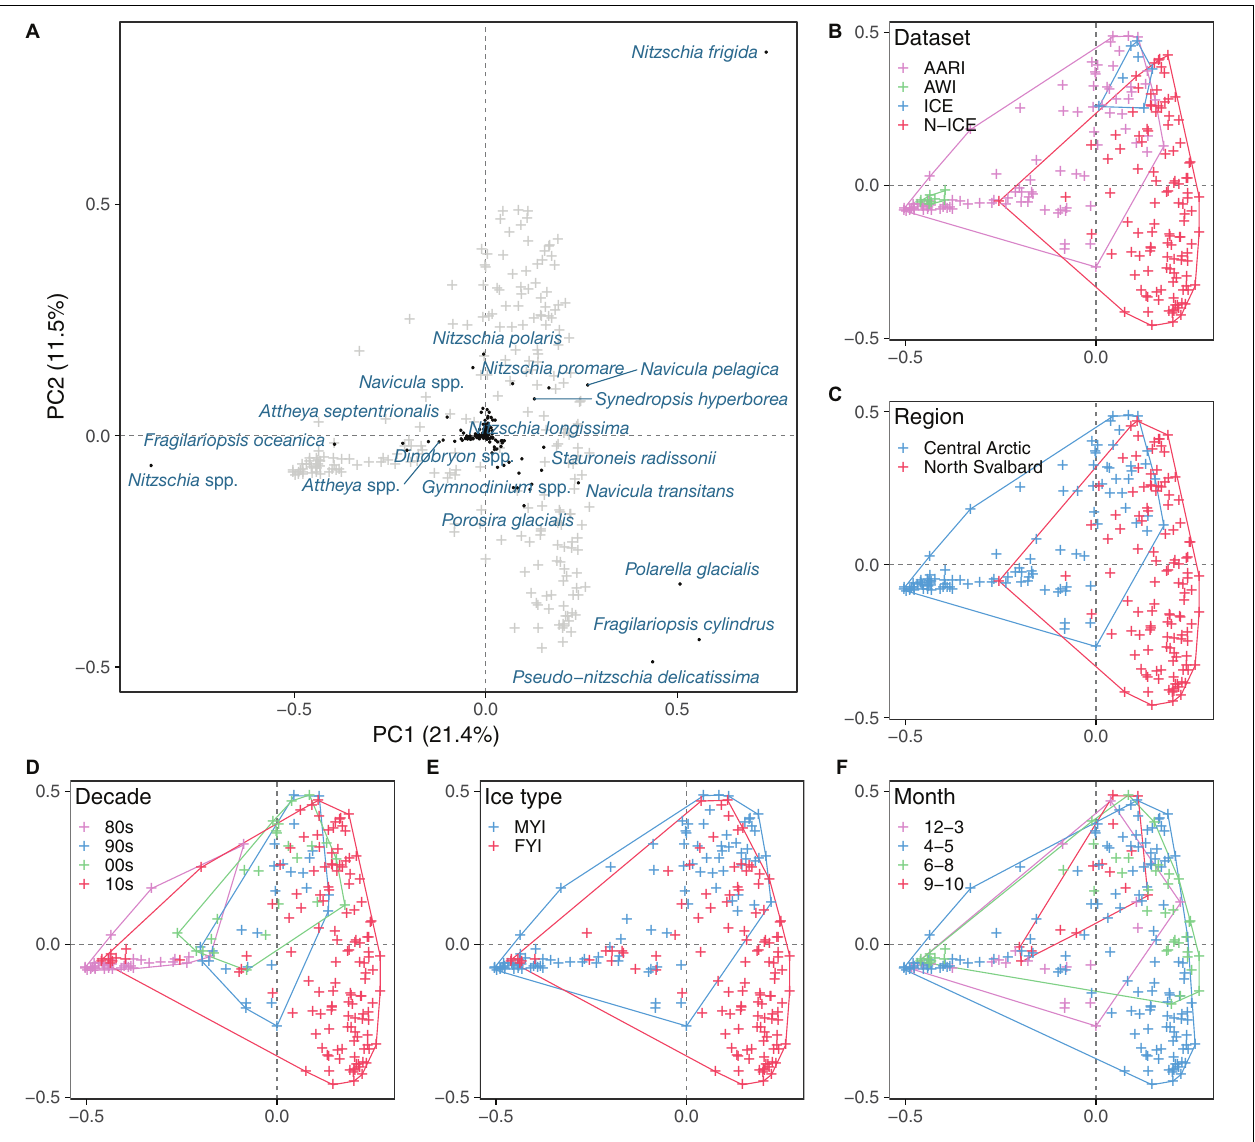
FIGURE 5 | Principal component analysis of Hellinger-transformed ice protist taxon abundance matrix. (A) Overview of taxa (black dots and blue text) in relation to ice cores (gray crosses). Ice cores (i.e., samples) related to dataset (B) , region (C) , decade (D) , ice type (E), and month (F) , with colored envelopes encompassing different